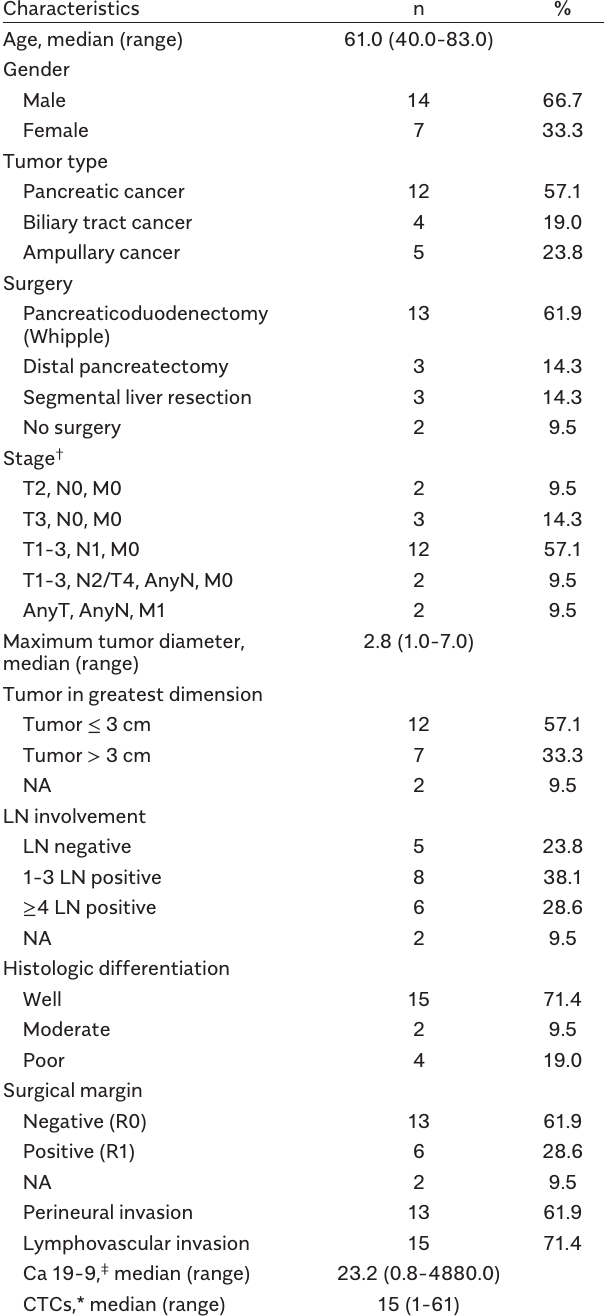
Table 1. Clinicopathological Characteristics of Patients